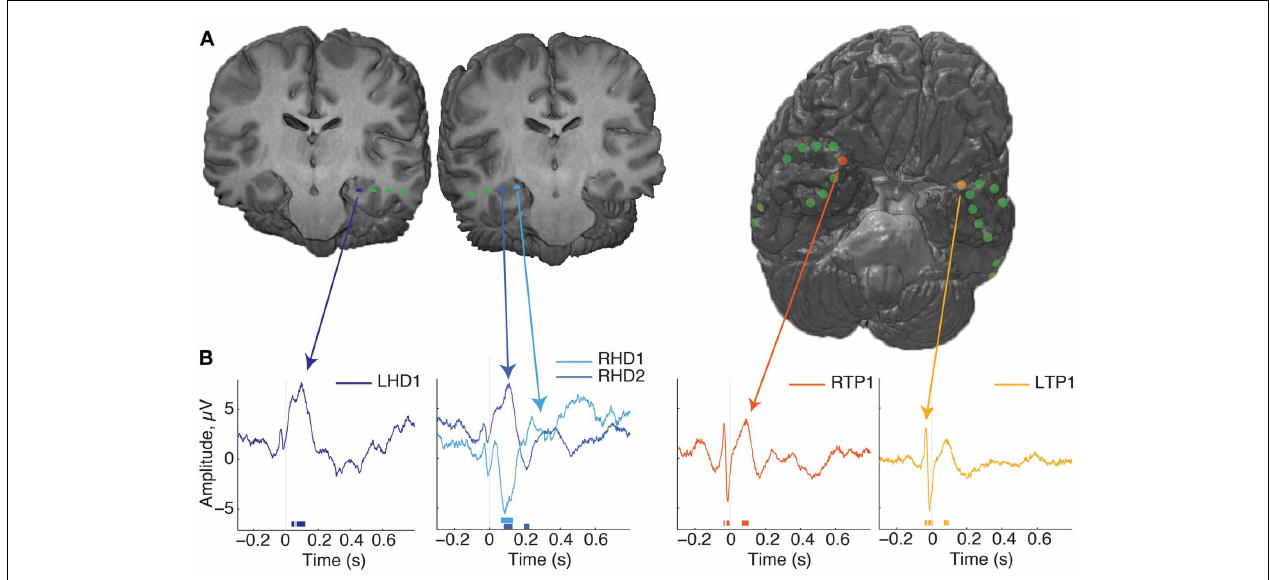
FIGURE 2 | Localization of electrodes and evoked responses. (A) Renderings from patient 1’s MR images with co-localized recording sites. On the left are two coronal sections showing the location of hippocampal depth macroelectrodes, with the most eccentric 1–2 contacts localized to the hippocampus, indicated by the blue dashes. On the right is a rendering of the whole brain, with the anterior tip oriented up and to the right, revealing the locations of subdural surface electrodes. This was the most common arrangement for the patients in this study. (B) Average evoked responses from several electrode locations, aligned to fixation onset. Time